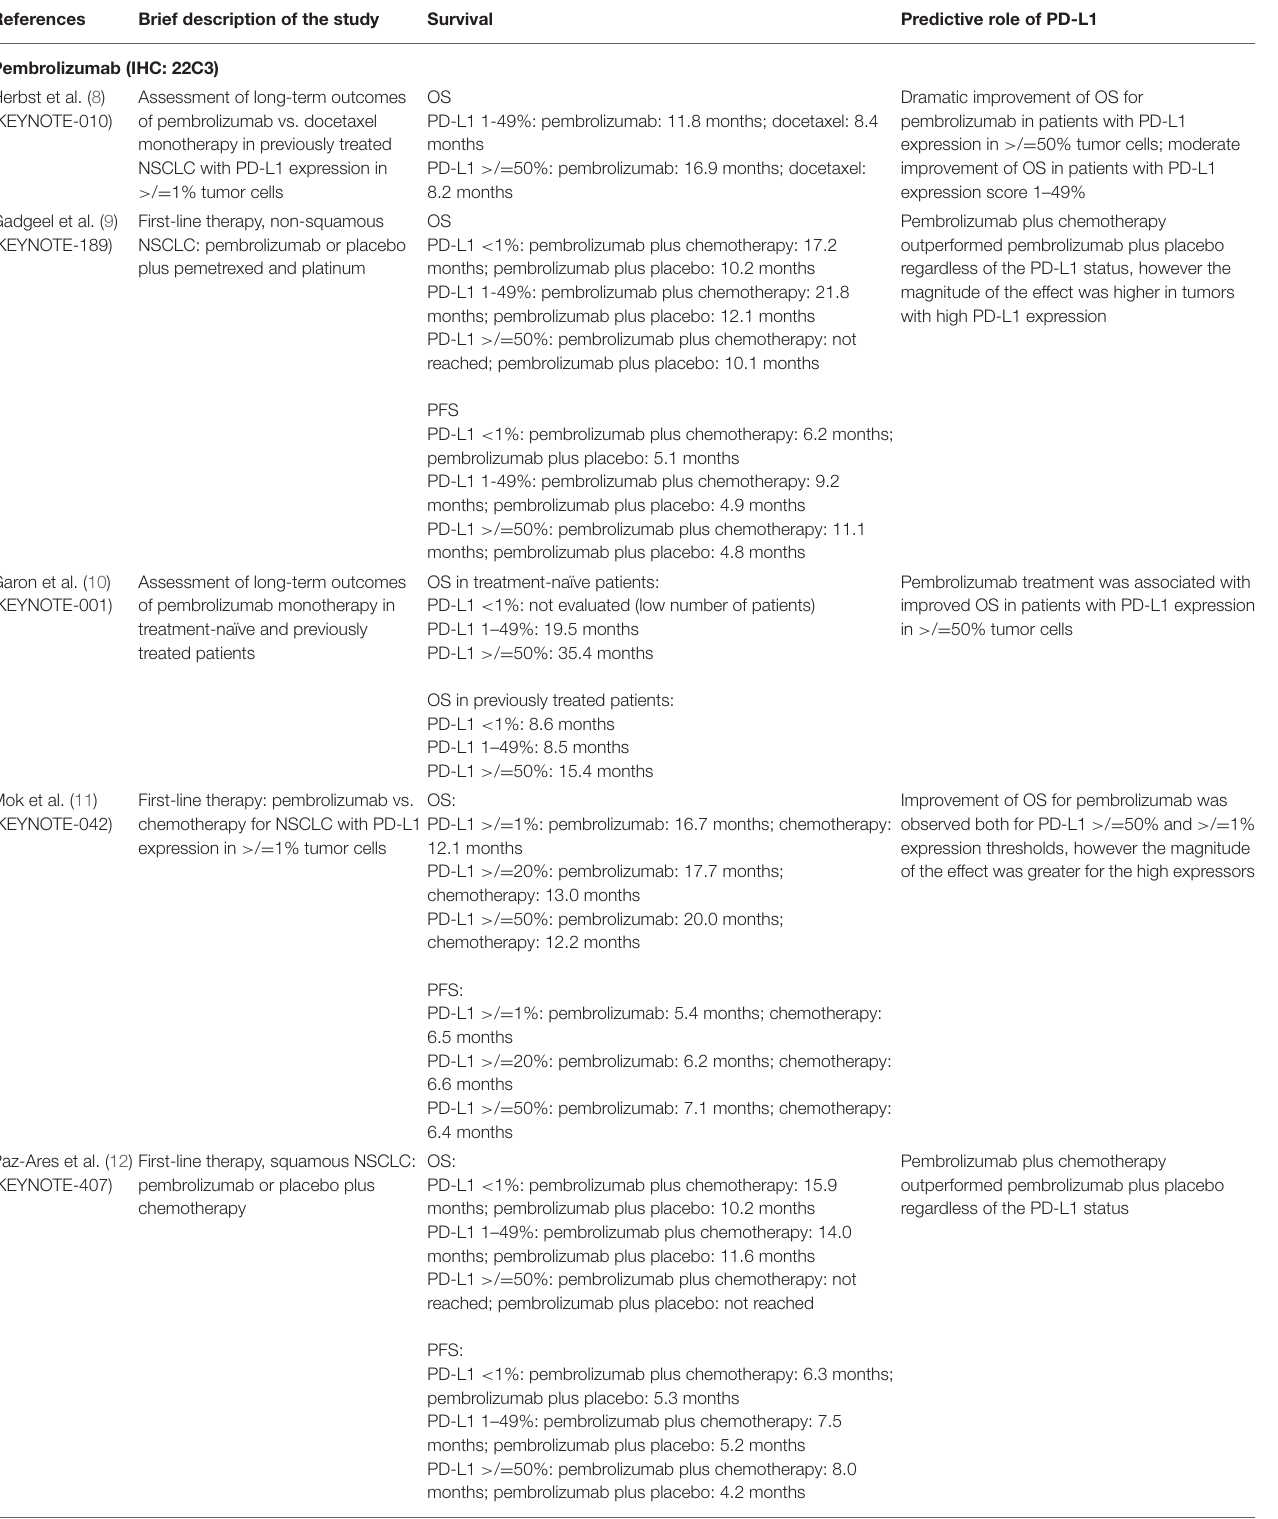
TABLE 1 | Selected clinical studies on immune checkpoint inhibitors, which evaluated associations between clinical outcomes and the level of PD-L1 expression